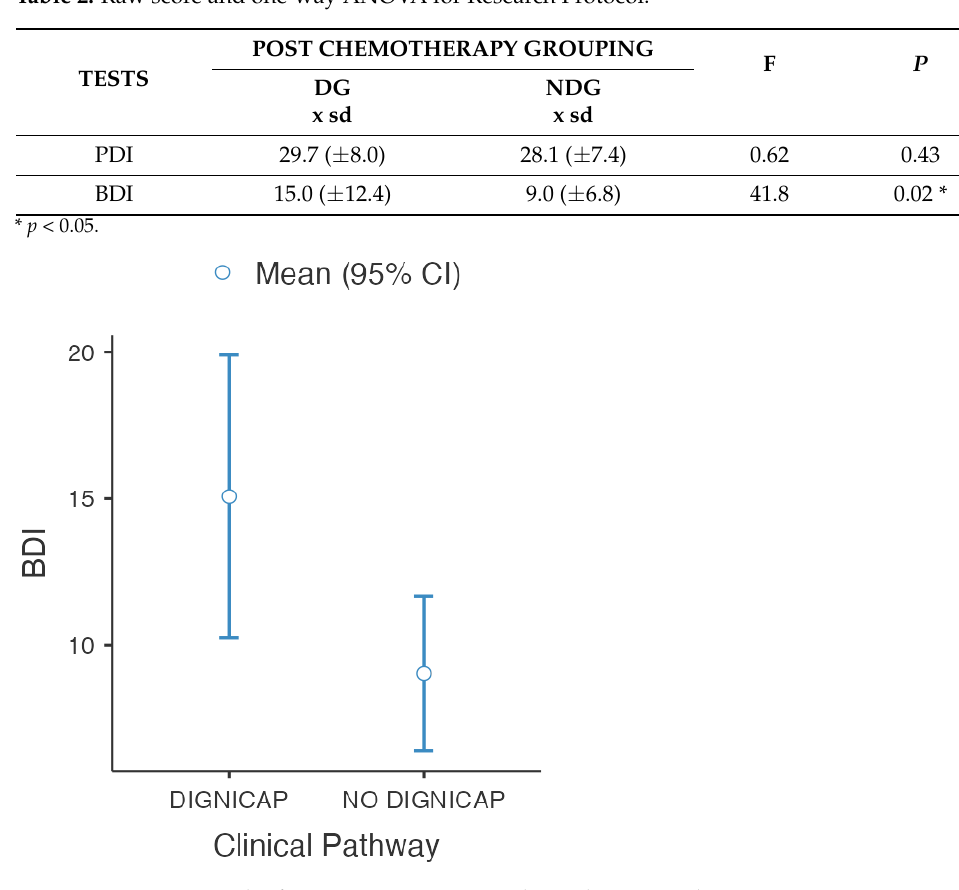
Figure 4. Descriptive Plot for BDI scoring in Post Chemotherapy